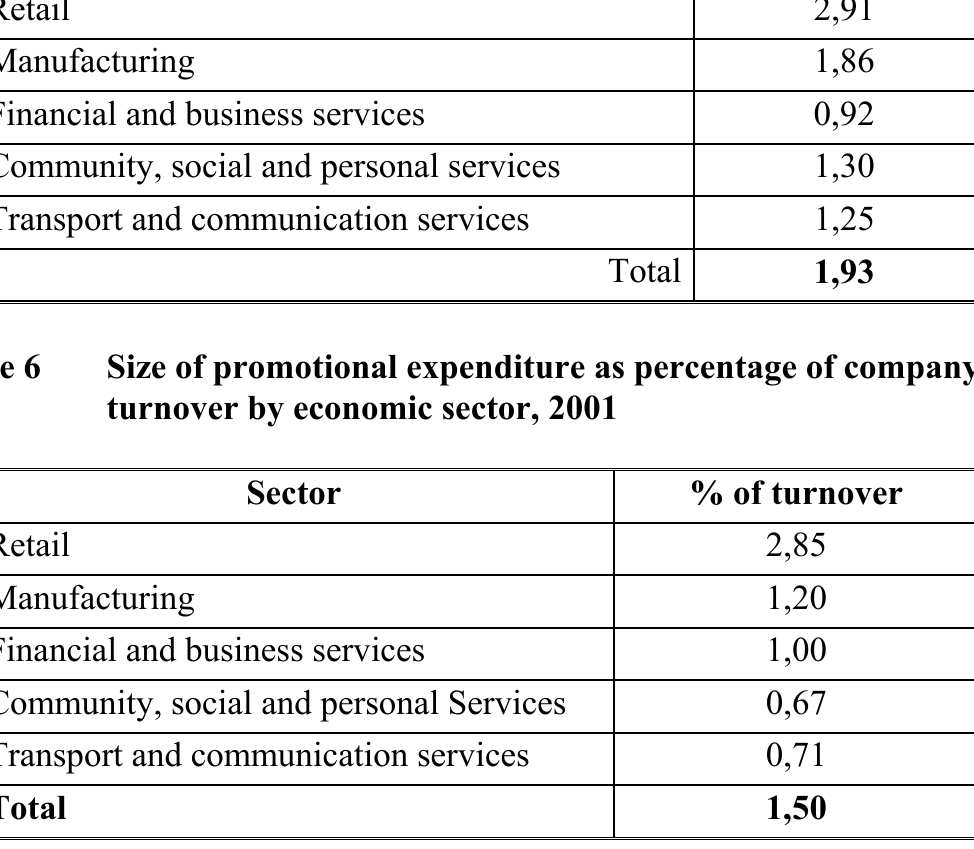
Size of advertising expenditure as percentage of company turnover by economic sector, 2001 Sector